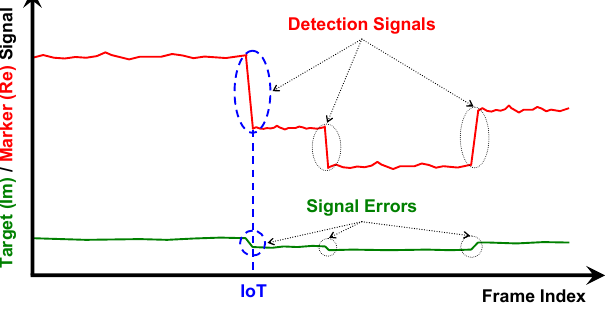
Fig. 1: Functional mechanism of the D&E technique. Green curve: imaginary target signal, red curve: real marker signal; IoT: index of truncation. The sharp jumps in the marker signal indicate the occurrence of unwanted target movements during measurement, and help to detect the corresponding erroneous changes in the target signal, which are of too small